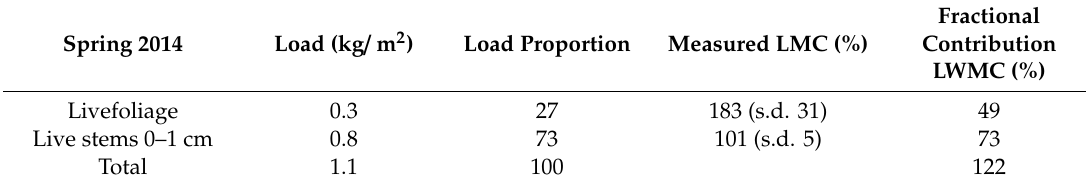
Table A2. Spring 2014 burn Live Moisture content estimates based on fuel loading in the sampled categories.